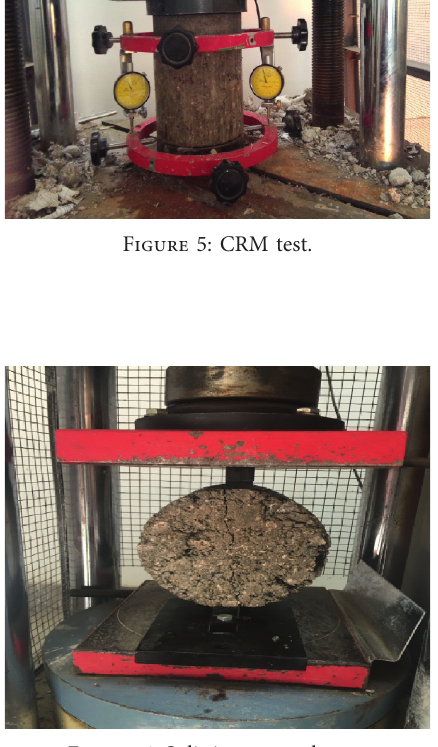
Figure 6: Splitting strength test.